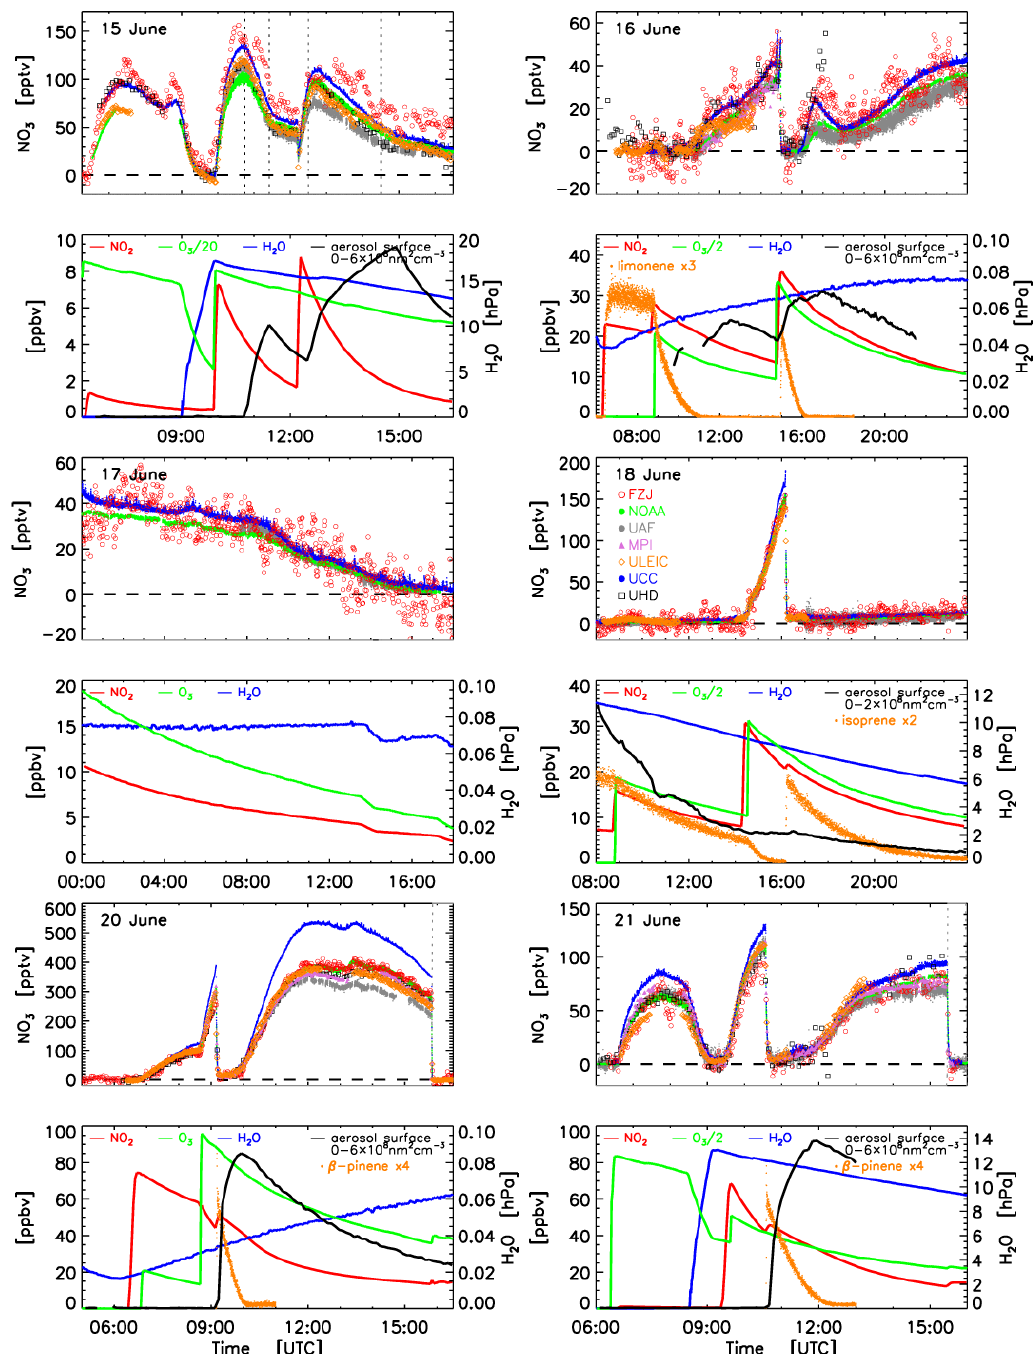
Fig. 4. Continued from Fig. 3. This figure comprises the chemically more complex experiments of the second part of the campaign. Dotted black lines on 15 June denote two time intervals during which inorganic aerosol was added to the